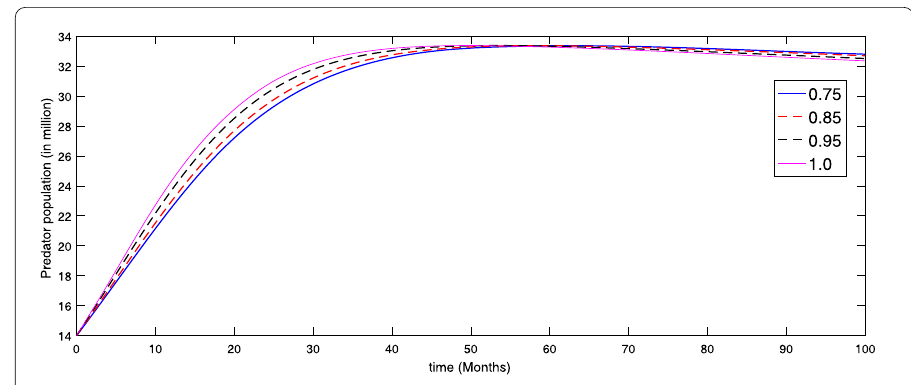
Figure 4 Graphical representation of the approximate solution v for different fractional order taking initial ten terms of the series in Case II